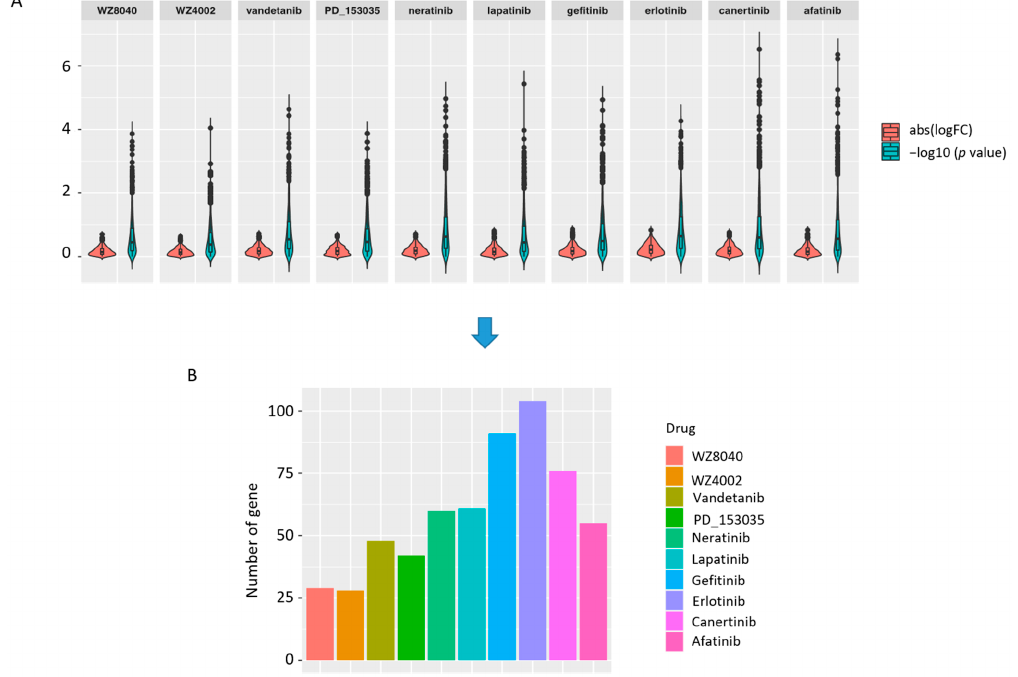
Figure 6. Results of difference analysis. ( A ) The violin plot shows the absolute value of logFC and − log10( p value) for each EGFR inhibitor. ( B ) The number of absolute value of logFC > 0.5 and the p value < 0.05 for each EGFR